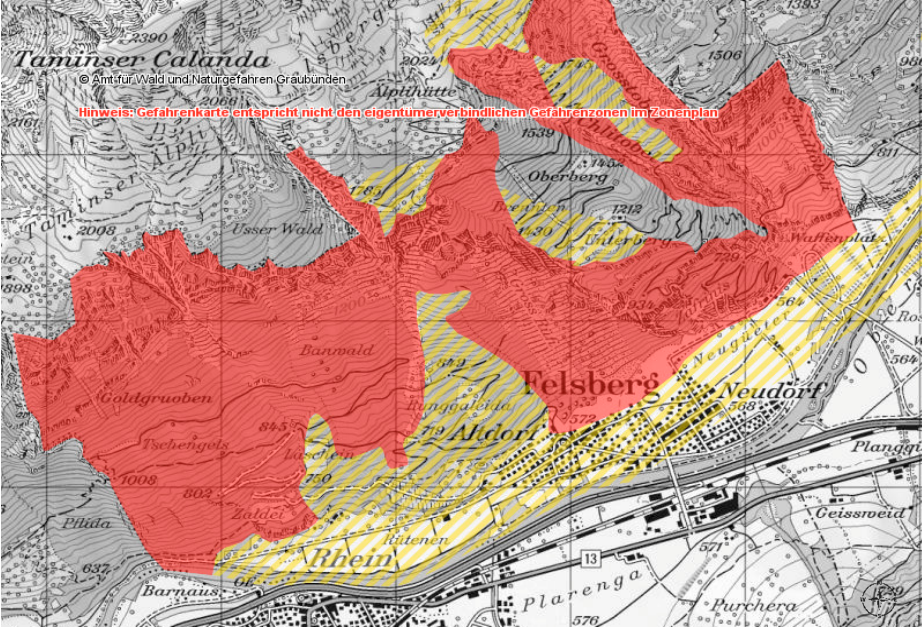
Figure 2. Natural hazard risk map of Domat-Ems: flood risk zones (Latitude: 46.833636 | Longitude: 9.447354; for all following figures: coordinates refer to the location of the community; © Canton of Grisons).